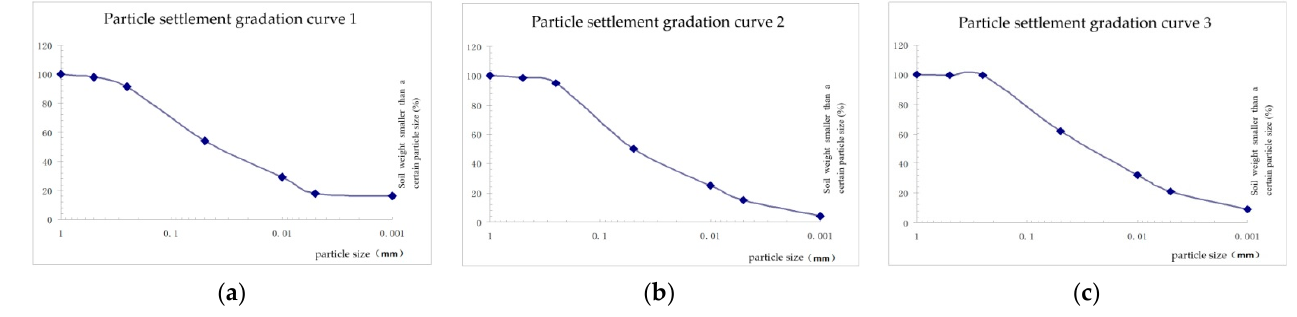
Figure 2. Particle size grading diagram of the test soil samples. Note: ( a ) 0–10 cm soil sample; ( b ) 10–20 cm soil sample; ( c ) 20–30 cm soil sample.